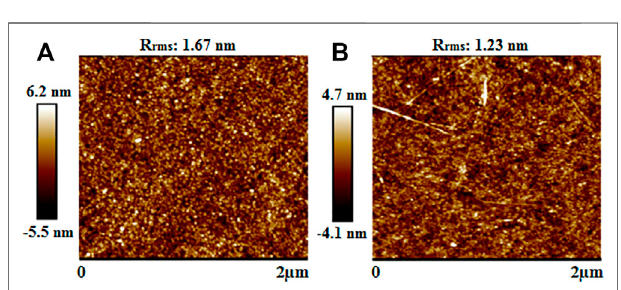
FIGURE 11 | AFM micrographs of (A) pristine ZnO NPs and (B) ASP- SWCNTs on ZnO NPs. Adapted with permission (Lee et al., 2020). Copyright 2020, American Chemical Society.